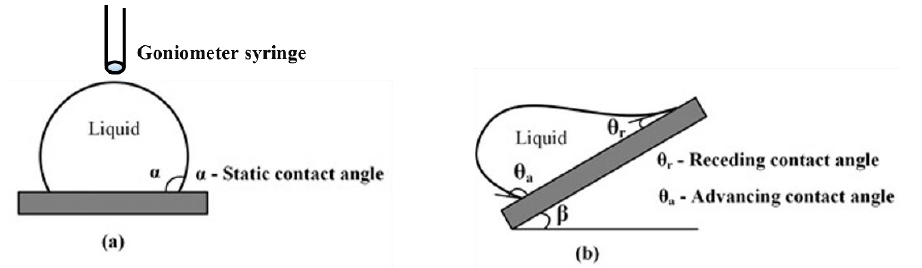
Figure 8. Water drop angles for hydrophobicity recovery measurements ( a ) Static contact angle on a horizontal surface; ( b ) advancing and receding contact angles on an inclined surface.